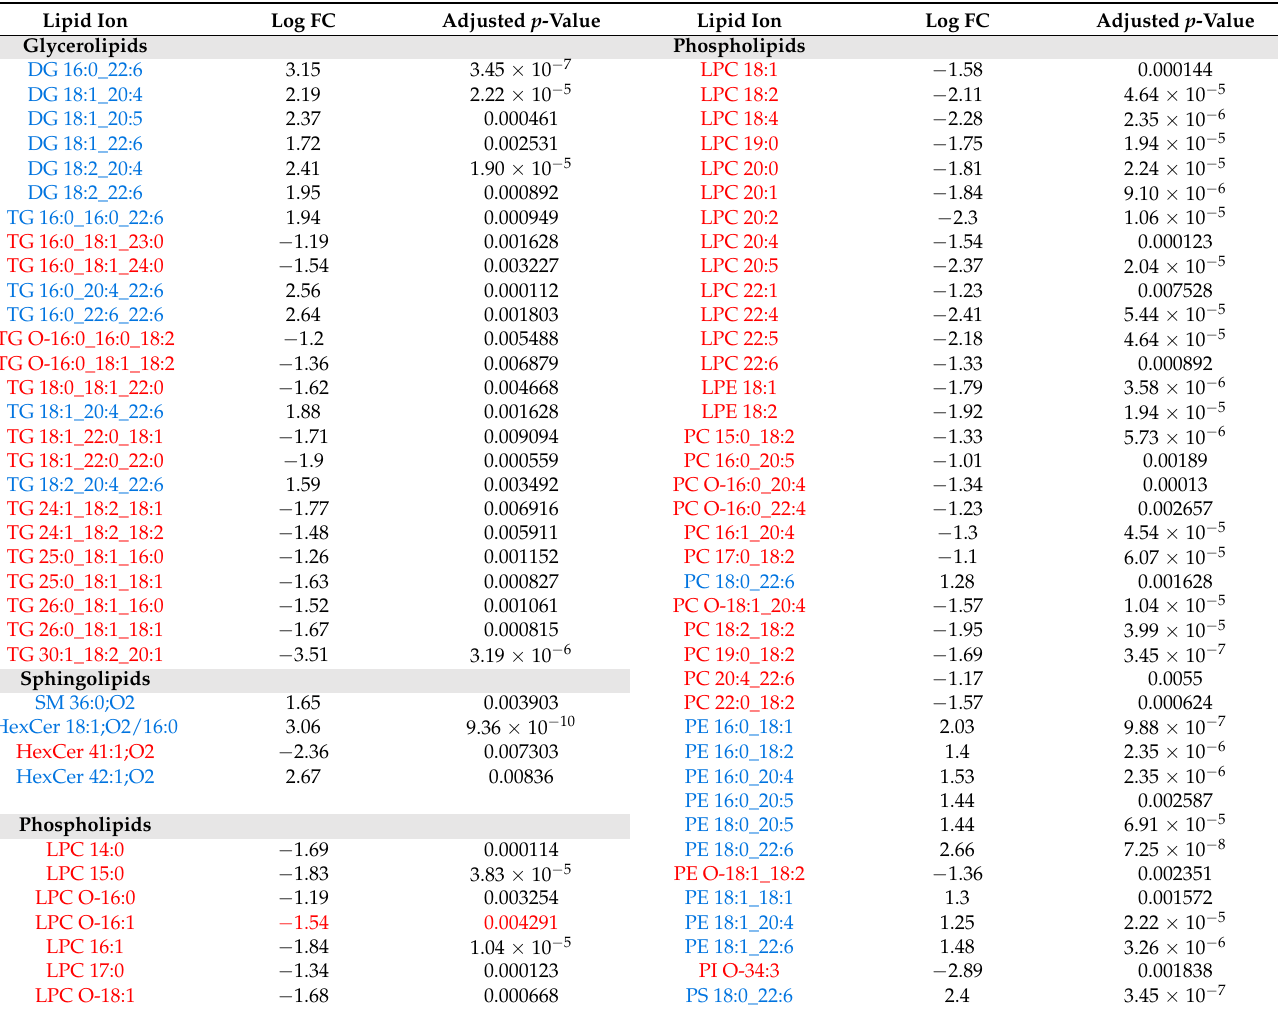
Table 1. Individual lipid molecules found at significantly different levels in PbA vs. control. Ions elevated (blue) and decreased in PbA are (red) were listed. Log2 fold-change (LogFC) and adjusted p -values are listed (i.e., moderated t -test and FDR correction). Ions are grouped into neutral lipids, sphingolipids and phospholipids and sorted alphabetically within each